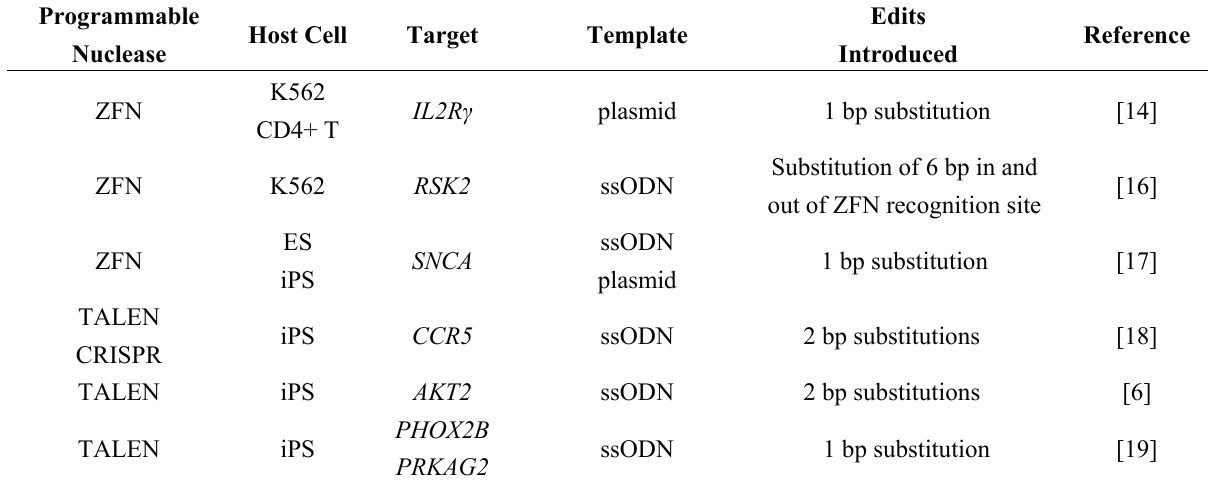
Table 1. Selection-independent seamless genome editing.